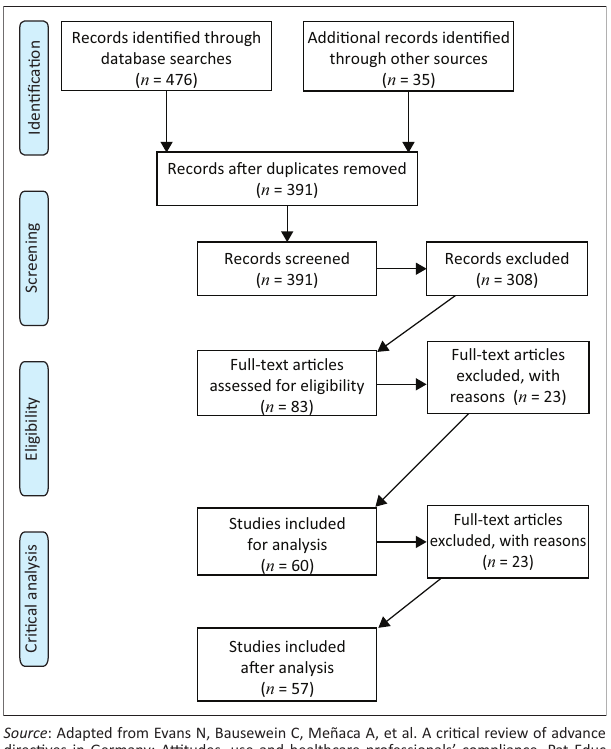
FIGURE 2: Preferred Reporting Items for Systematic Reviews and Meta-Analyses flow chart for the critical review of the